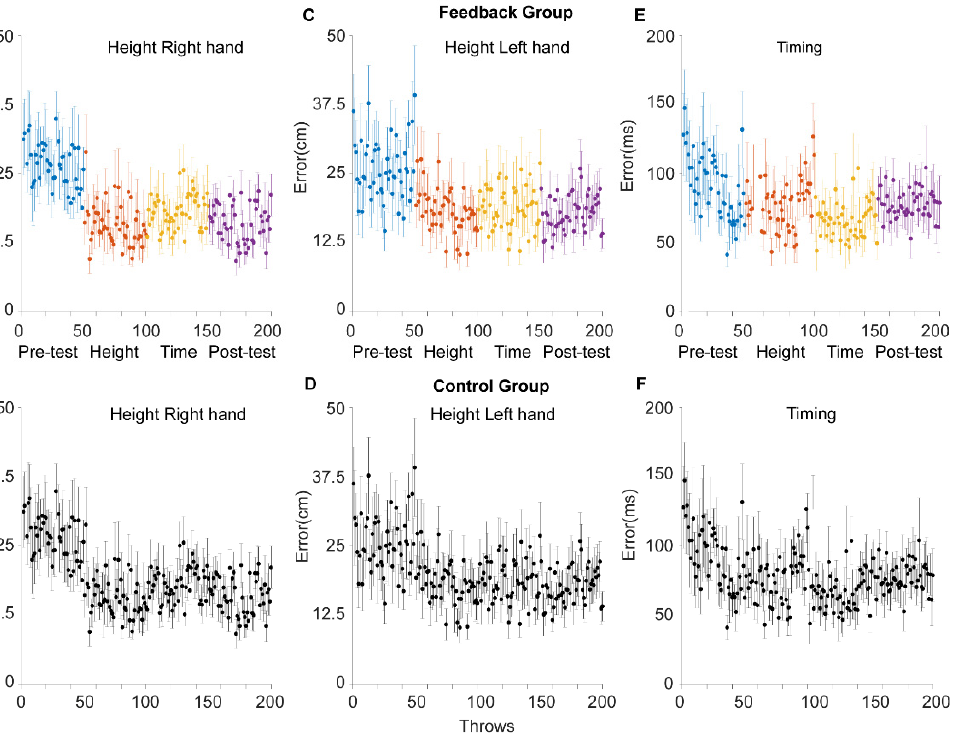
Figure 4. Height and timing errors (mean ± SEM) for participants receiving feedback (top row, colored lines/dots) and controls (bottom row, black lines). Panels A – E shows the difference between the optimal height of throws and the height of the actual throws with the right hand ( A , B ), and the left hand ( C , D ). Panels ( E , F ) shows the timing error. The color represents the stage of the experiment: blue represent baseline trials, before the participant received any feedback; red represent throws on trials where the participants received feedback on the height of their throws; yellow represent trials where participants received timing feedback; and purple represent post-feedback trials where participants did not receive any